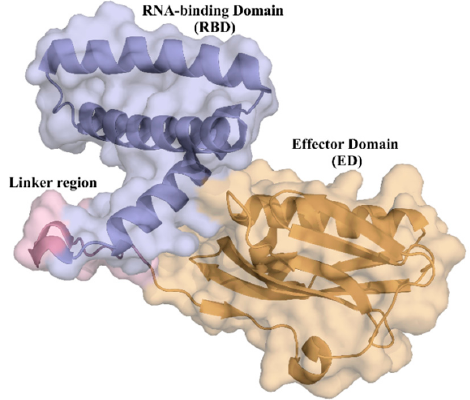
Figure 1. Cartoon depiction of the tridimensional crystal structure of the full-length monomer of NS1 from H6N6 influenza virus with its two structural domains highlighted (Protein Data Bank (PDB) access number 4OPH): the RNA-binding domain (blue) comprising three α -helices; and the effector domain (orange) with α -helices and β -strands. The two domains are connected by a linker region (pink).